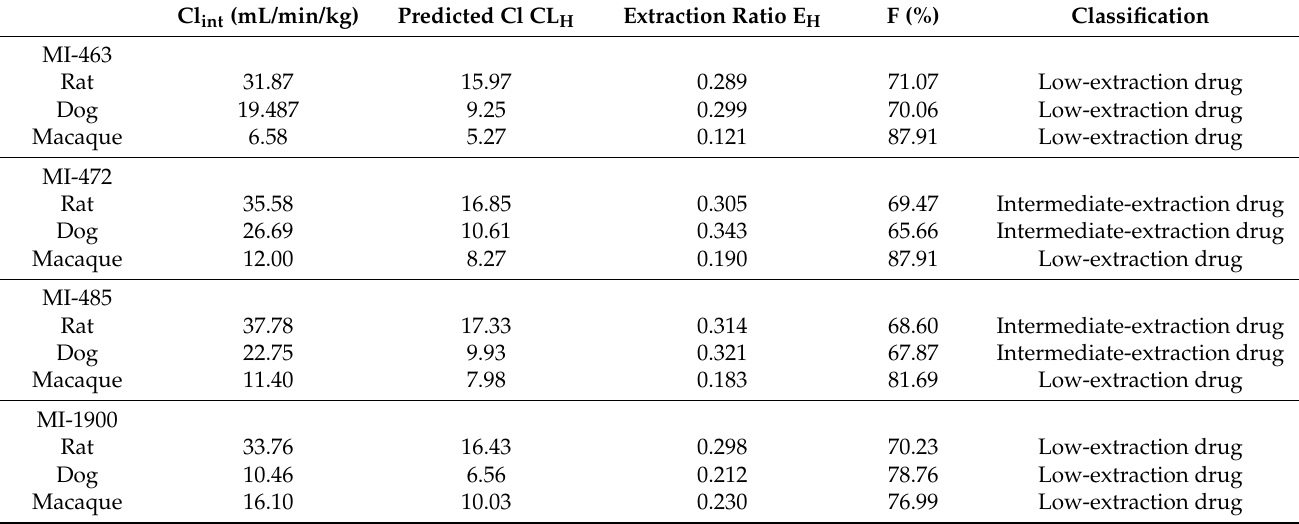
Table 2. Summary of rat, dog and macaque pharmacokinetic parameters of inhibitors. F